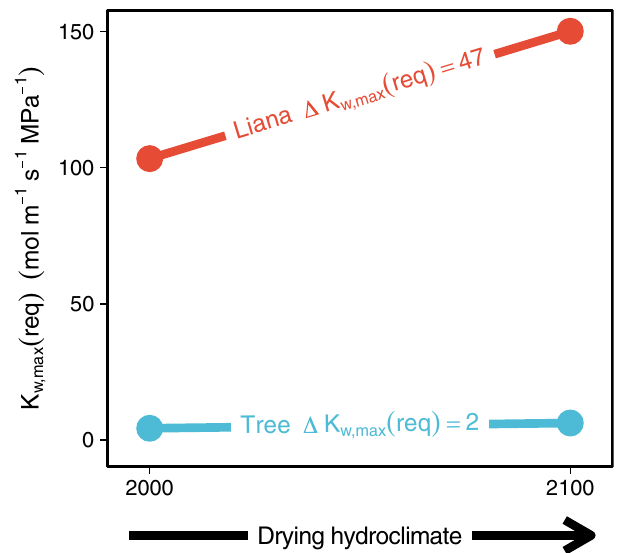
Fig. 4 Liana required maximum whole plant hydraulic conductivity (K w,max (req)) is more sensitive to drying hydroclimate than tree K w,max (req). Increase in liana and tree K w,max (req) under present (2000) and future (2100) climate conditions at the tropical dry forest site (Horizontes, Costa Rica). K w,max (req) is computed under the established liana scenario (60% tree leaf area, 40% liana leaf area of 200 m 2 total leaf area). Blue: tree K w,max (req), red: liana K w,max (req). Lines and labels depict the change in K w,max (req) from present to 2100 for each growth form with units of mol m − 1 s − 1 MPa − 1